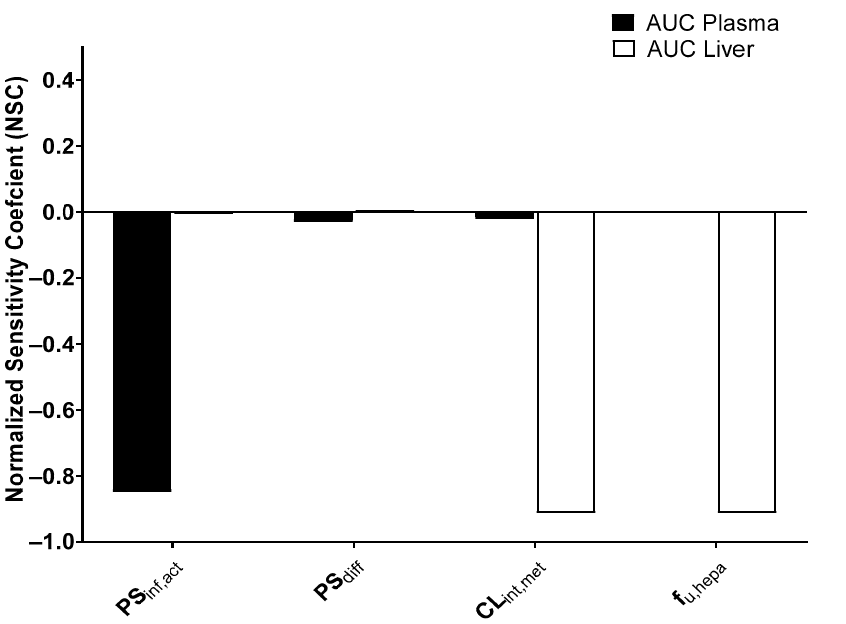
Figure 9. Local sensitivity analysis for the mPBPK modeling in the liver and plasma of the control group. trol group.